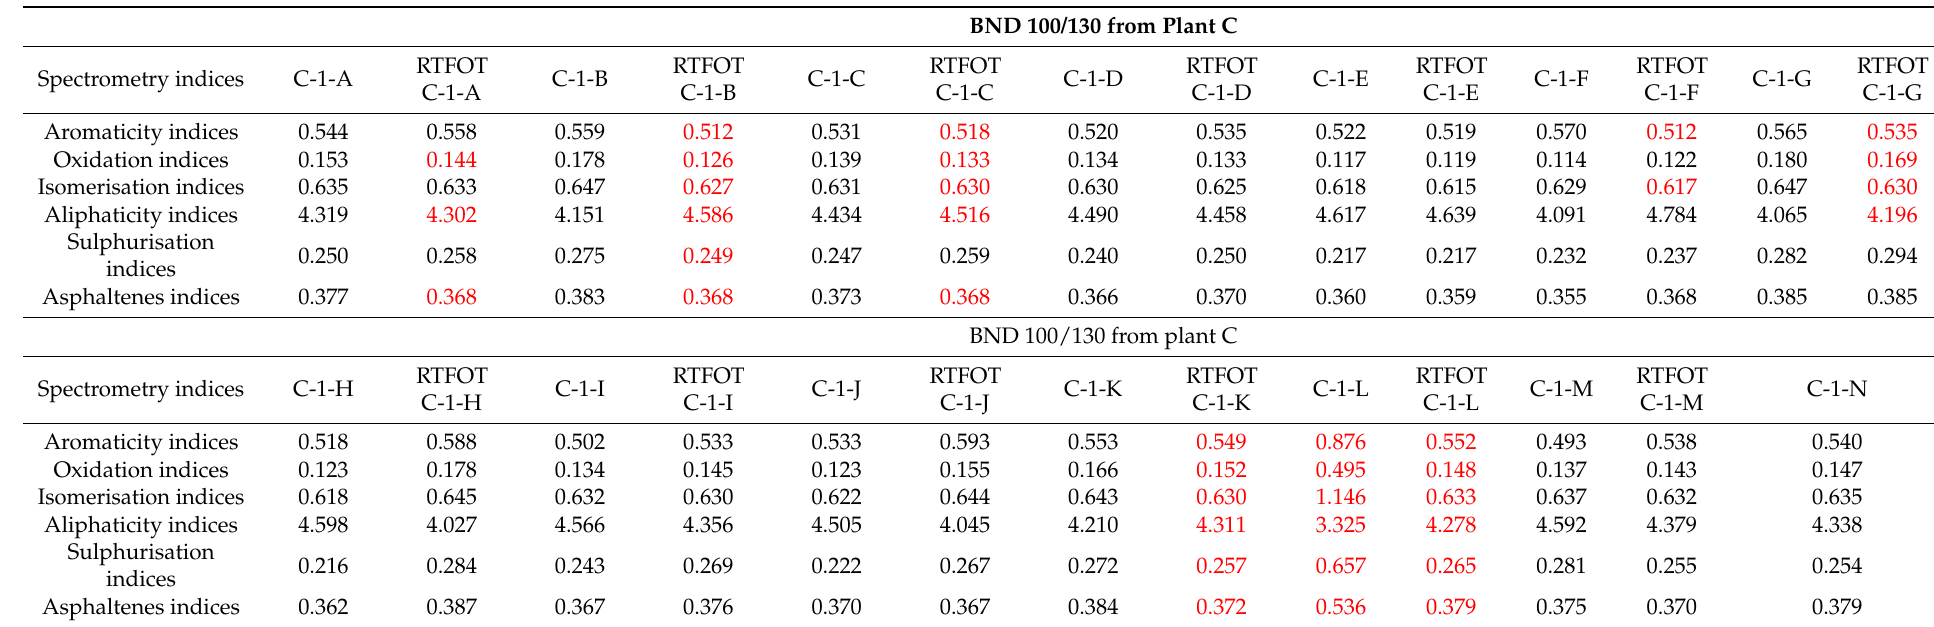
Table 11. Calculation of spectrometry indices of BND 100/130 from plant C before and after